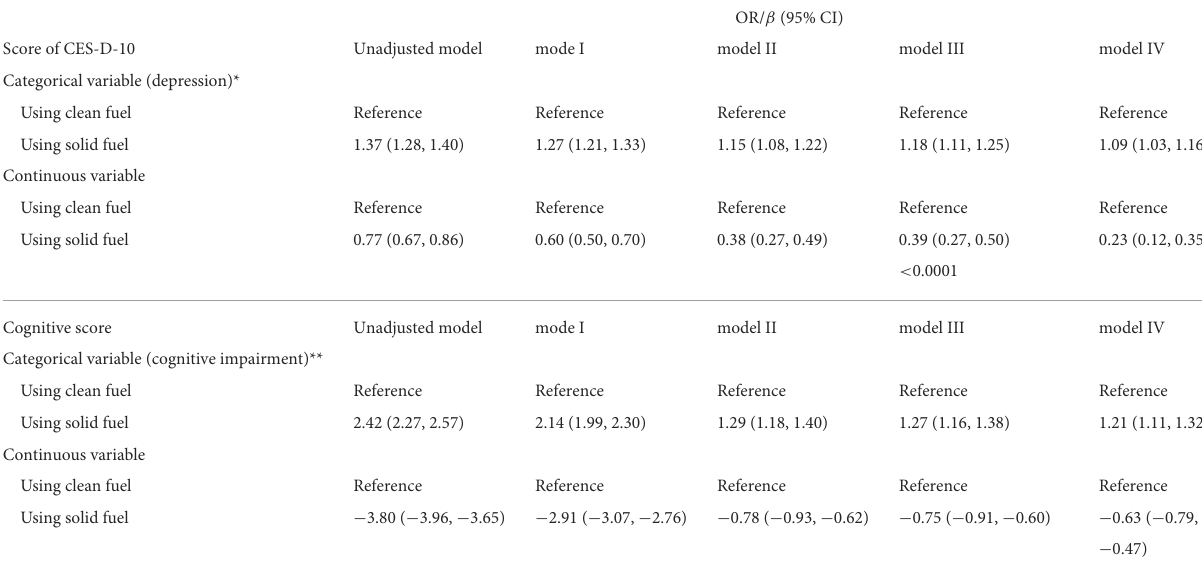
TABLE 2 Association of using solid fuel with symptoms of depression, CES-D-10 score, cognitive impairment, and cognitive scores.